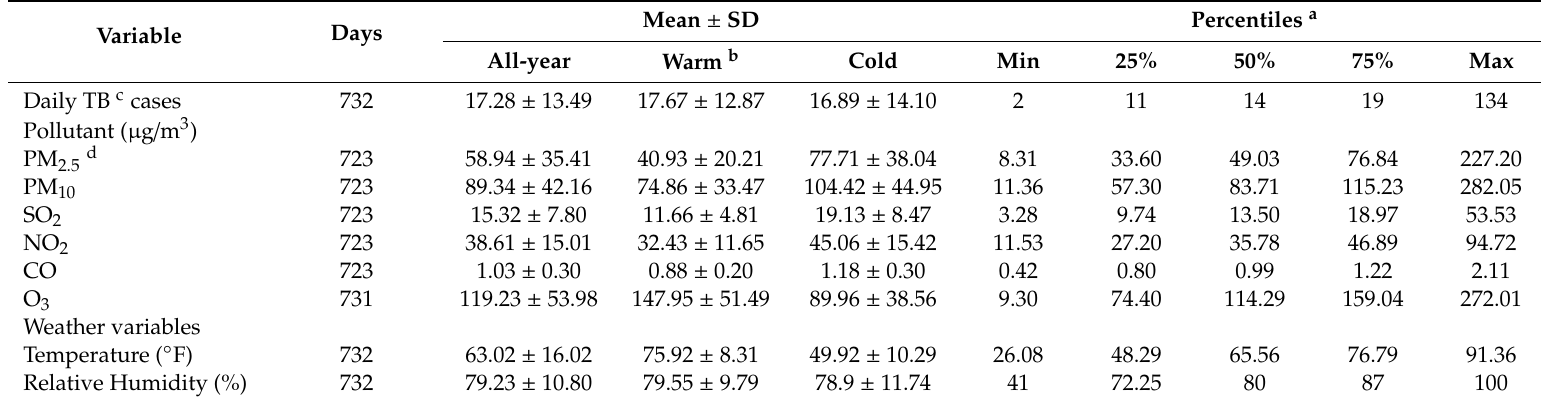
Table 1. Descriptive statistics of TB incidence counts, air pollutants, and meteorological variables in Wuhan, China, during the 2015–2016 period.